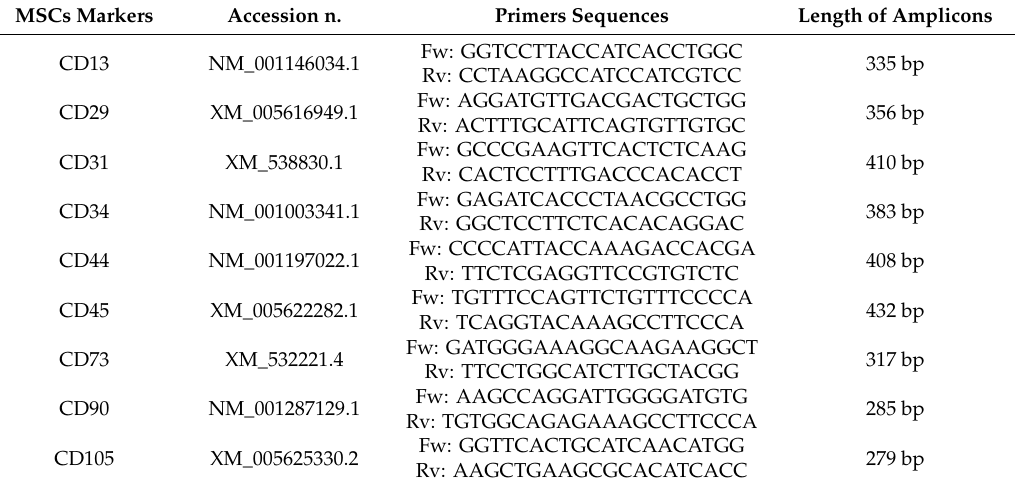
Figure A3. Graphic representation of experiments performed with ADMSCs to determine cell growth by colorimetric MTT assay, on plastic surface or inside a 3D environment. The same experimental scheme was applied, while different culture times and supplementations were used, as described in the Material and Methods section. Cells were maintained in 96 well plates. Table A1. Markers used for the evaluation of gene expression in canine ADMSCs and SVF cells by RT-PCR.